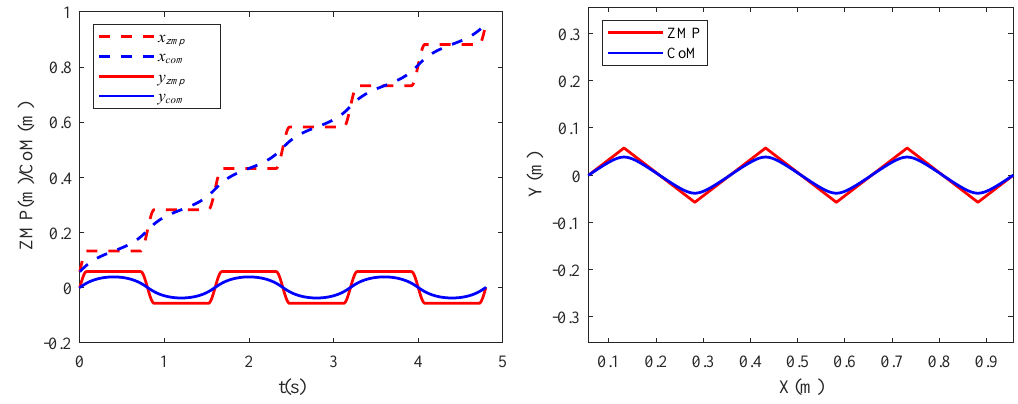
Figure 8. ZMP and CoM trajectory in three cycle. The ( left ) image shows the ZMP and CoM trajectories in X and Y directions, respectively. The ( right ) image shows the composite motion in the XOY